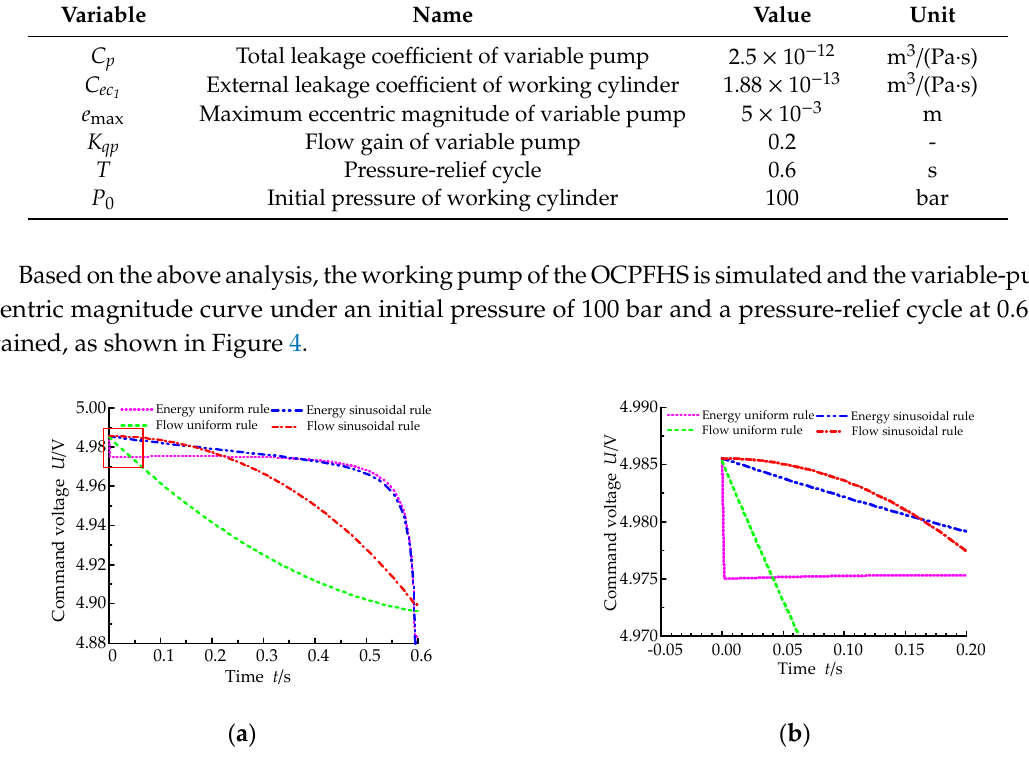
Figure 4. Simulation curves of variable-pump eccentric magnitude changes under the different pressure-relief rules. ( a ) Eccentric magnitude curve; ( b ) Partial magnification.